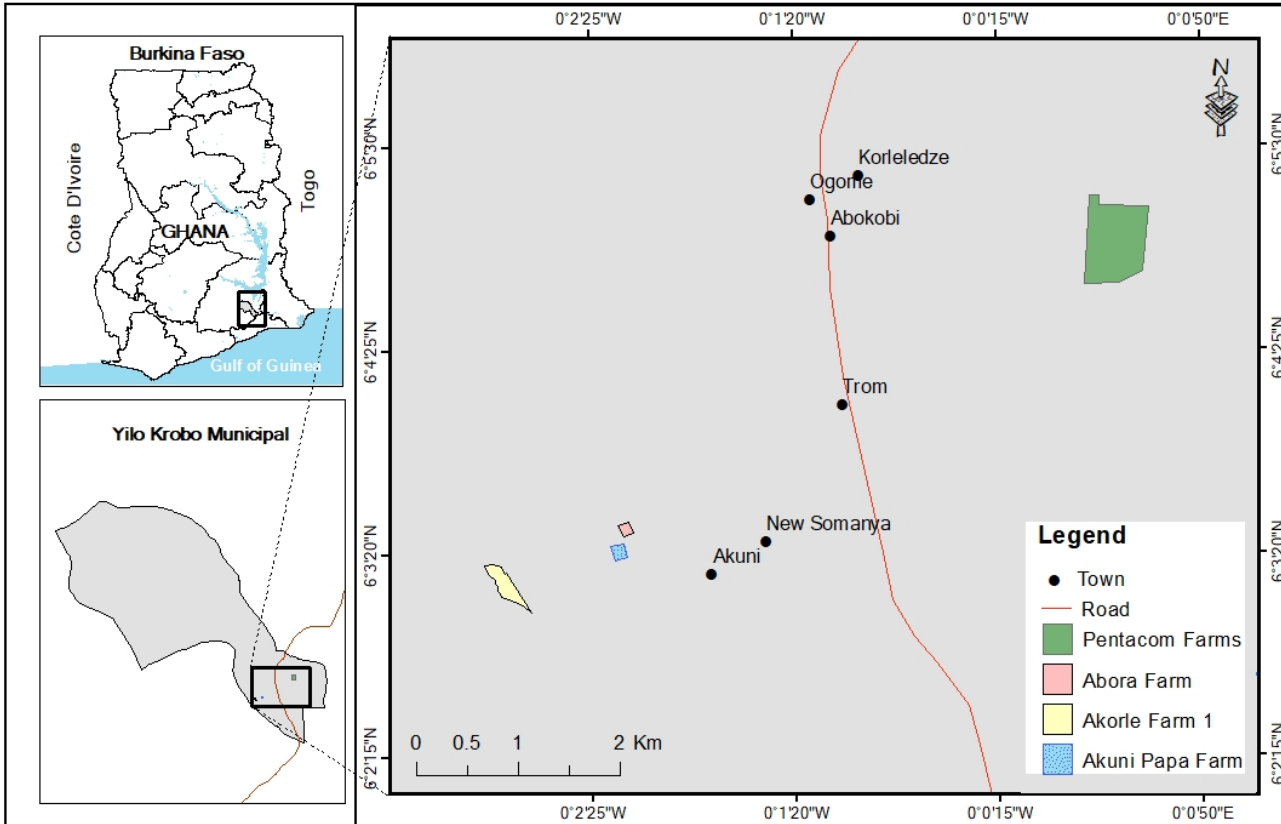
Figure 1. Study area map showing the four mango farms in the Yilo Krobo Municipal Area-Eastern Region, Ghana. Table 1. Description of the four farms used in the study.